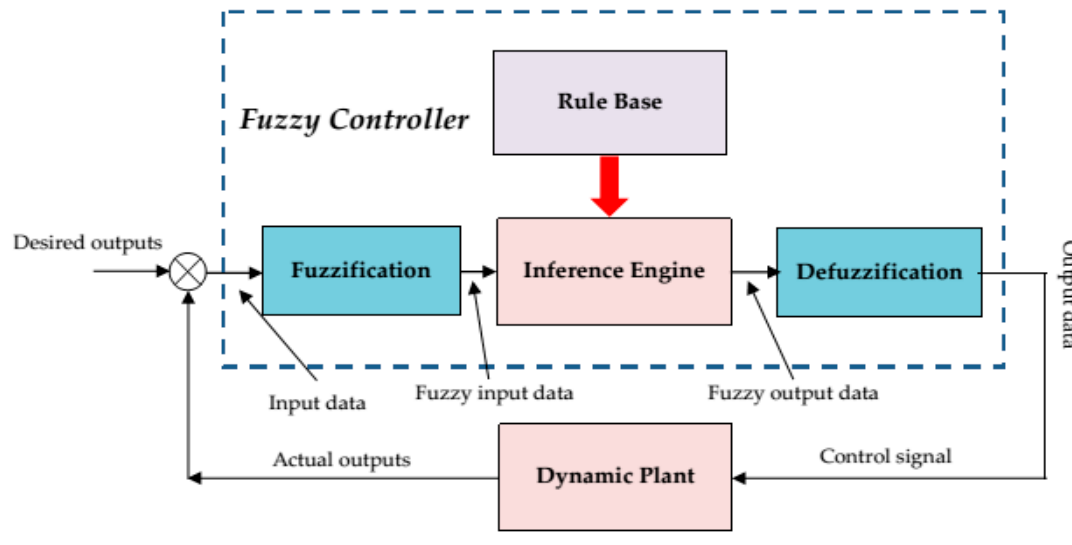
Figure 6. Block diagram of fuzzy logic control.